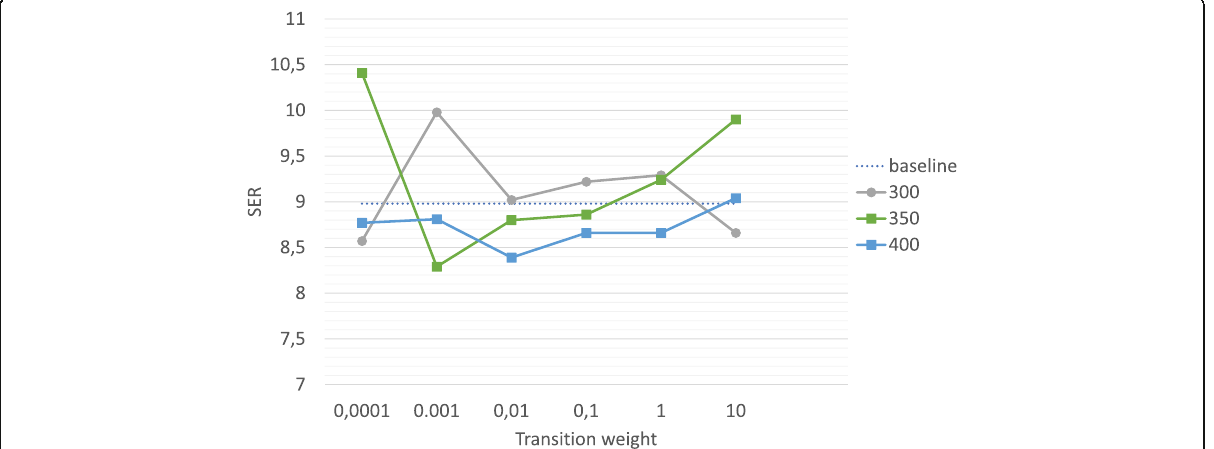
Fig. 6 SER for the DEVELSET for a single mfcc stream across different values of the transition weight and different minimum durations of a speaker turn of 300, 350, and 400